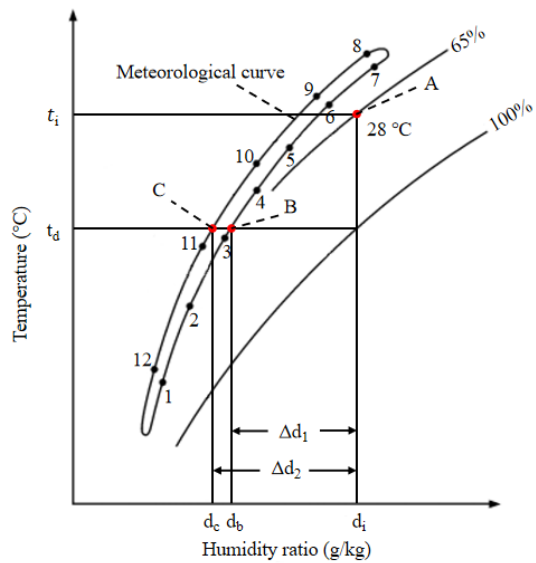
Figure 2. Principle diagram of ventilation-curve method.